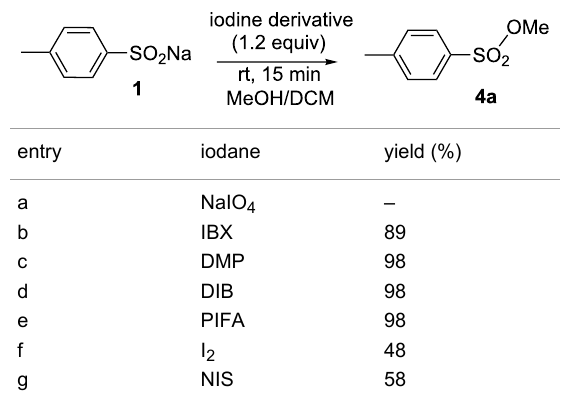
Table 1: Oxidative sulfonylation process mediated by iodine and iodine derivatives.